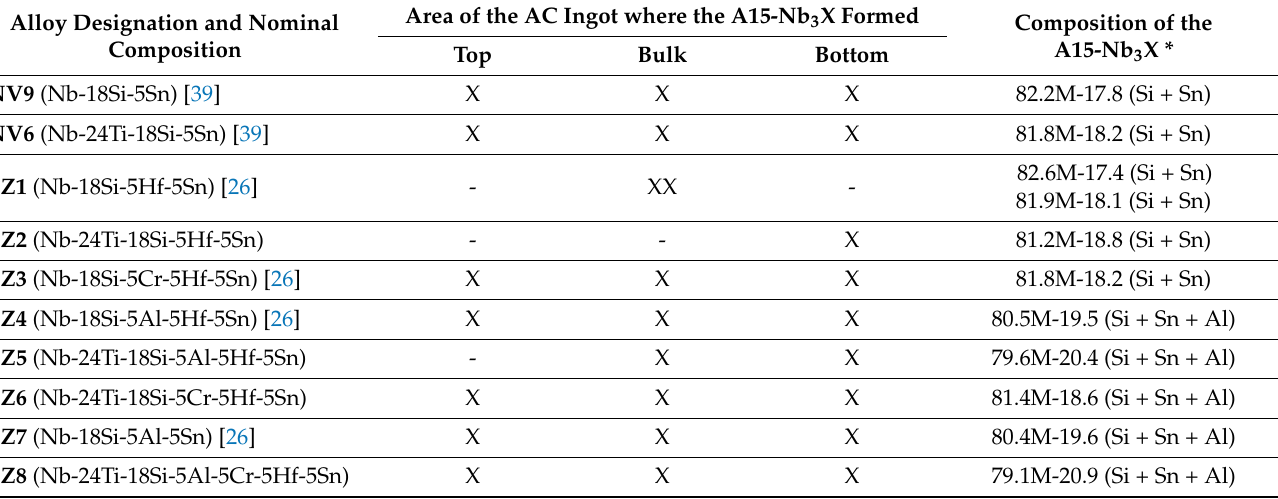
Table 9. Effect of the different alloying elements on the formation and composition (at.%) of the A15- Nb 3 X compound in various as-cast